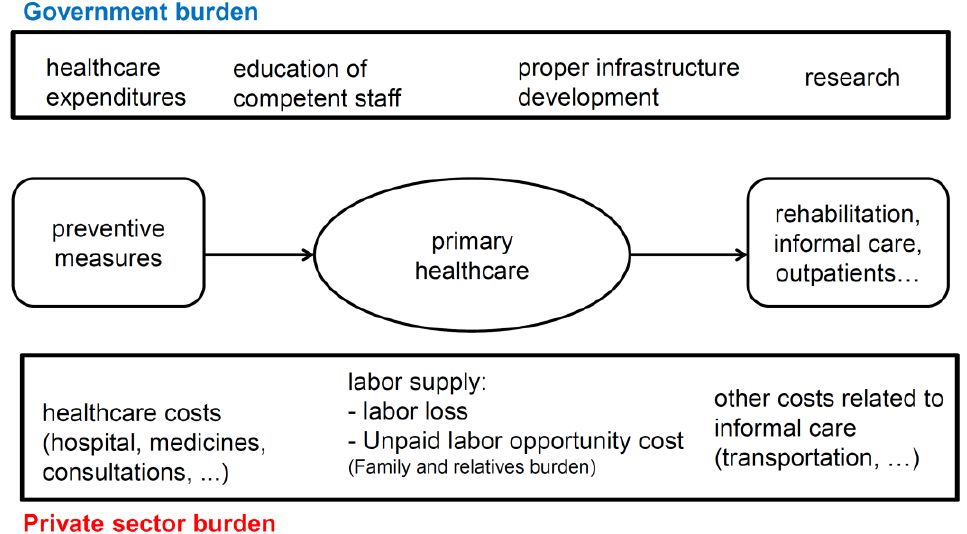
Figure 3. Costs structure of lung cancer and severe respiratory diseases. Source: Depicted by the authors.